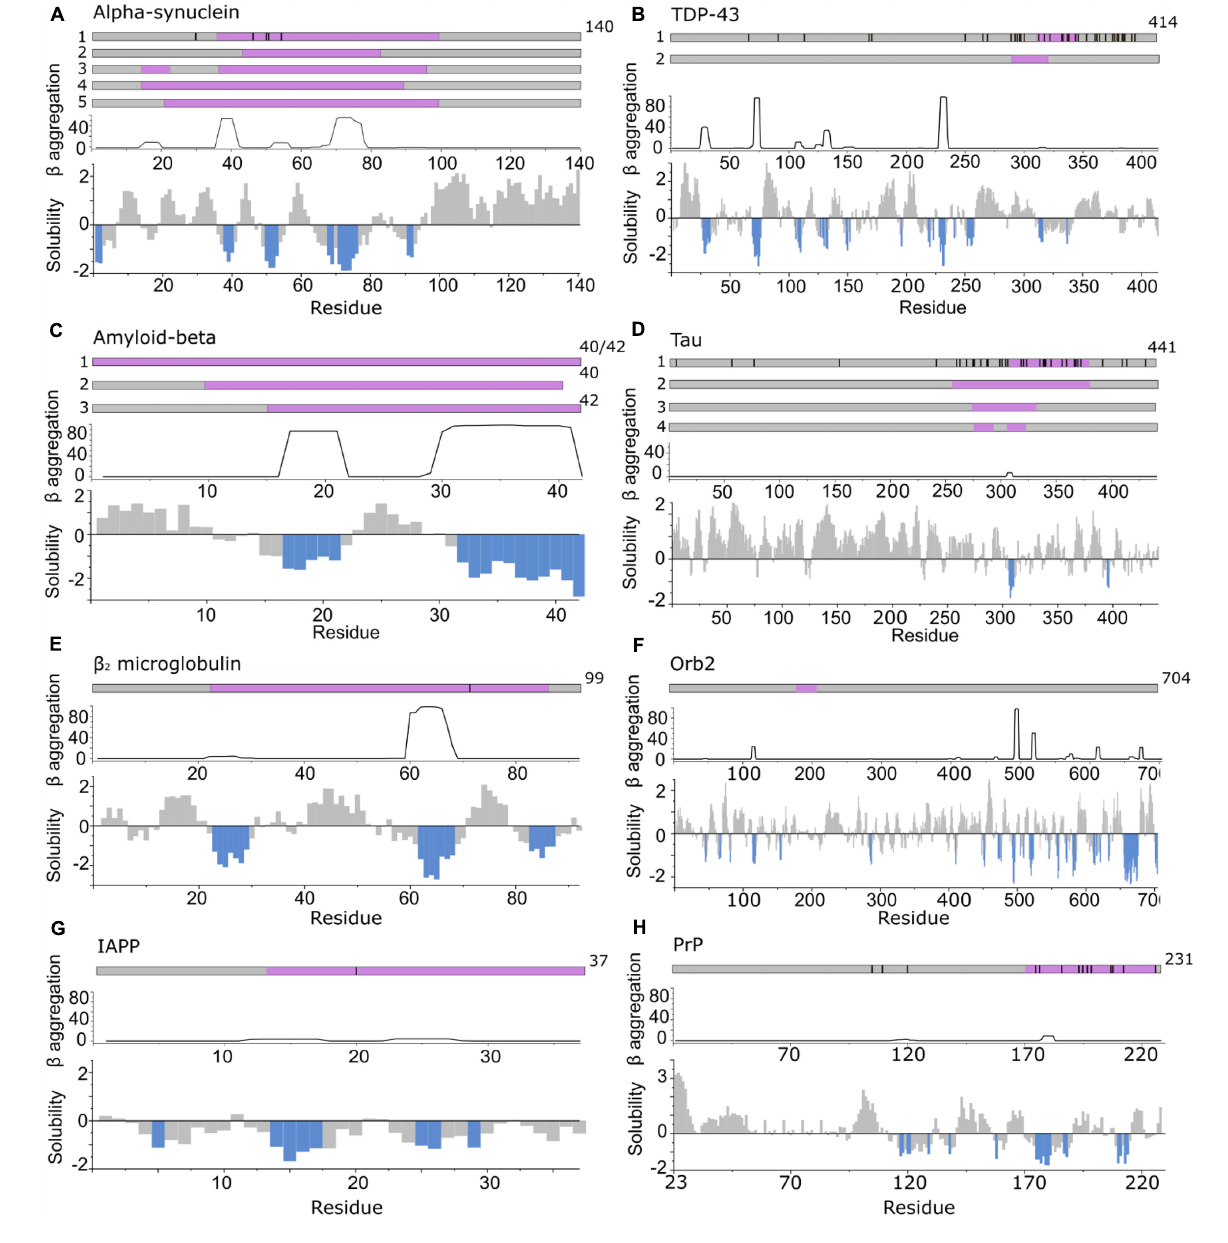
Frontiers in Neuroscience |